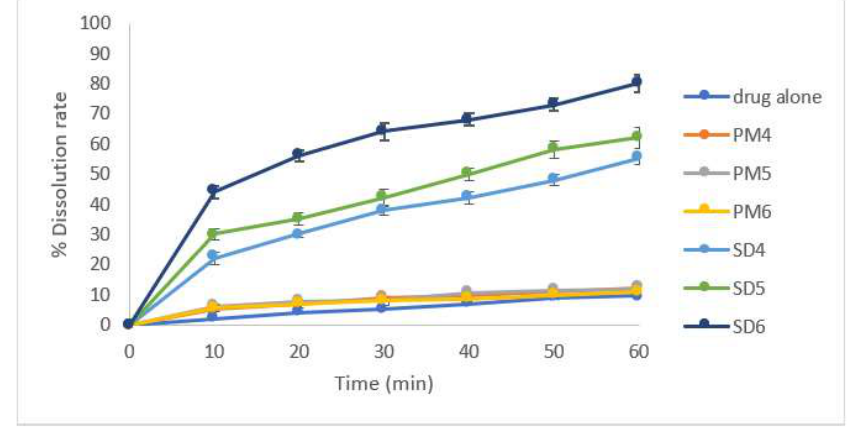
Figure 4. Enhancement of dissolution profile of Clonazepam/PEG 6000 PMs and SDs.